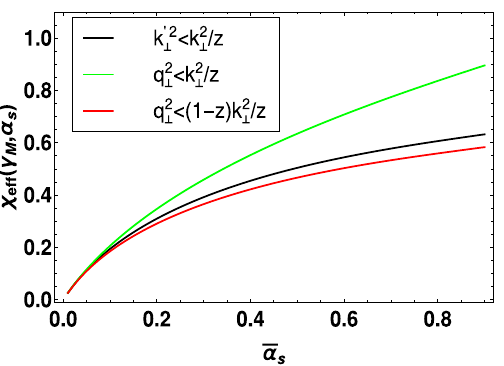
Fig. 3 The values of the intercept ω P = χ eff (γ M , ¯ α s ) , Eq. (70), as a function of ¯ α s for different choices of the kinematical constraint